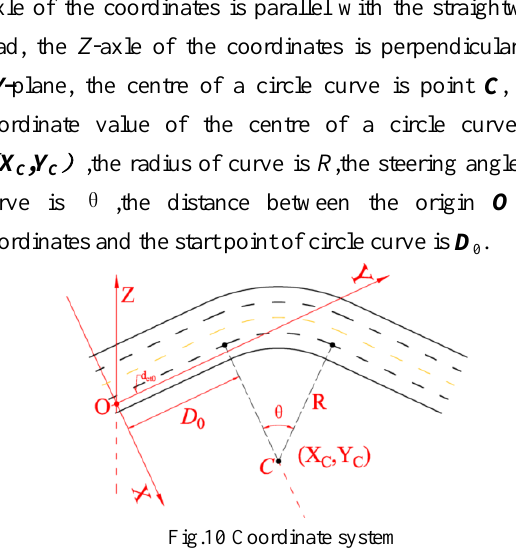
Fig.7 Concave curve of the driver’s desired trajectory (d) （ 5 ） The driver always desire to drive along the middle line of the lane, the ending point of the desired trajectory is the same with the natural curve. And the curvature of the desire trajectory is still the same.